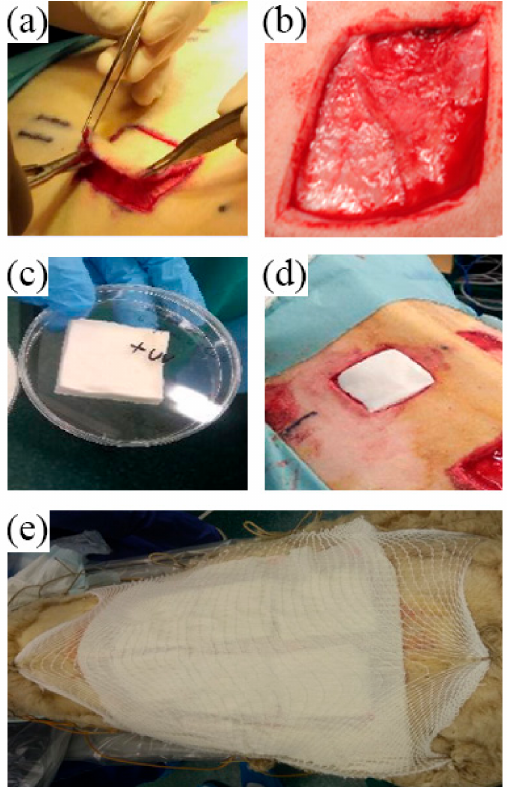
Figure 2. Representative images of the surgery procedure and biomaterial implantation. ( a ) Skin full- thickness removal by using surgical scissors for detaching the dermis from the subcutis; ( b ) macro- scopic appearance of the wound after surgery; ( c ) 3D scaffold after UV sterilization and before implantation; ( d ) 3D scaffold implantation in the wound, the biomaterial was directly placed onto the wound bed; ( e ) representative figure of the bandages applied to the back of each sheep after the